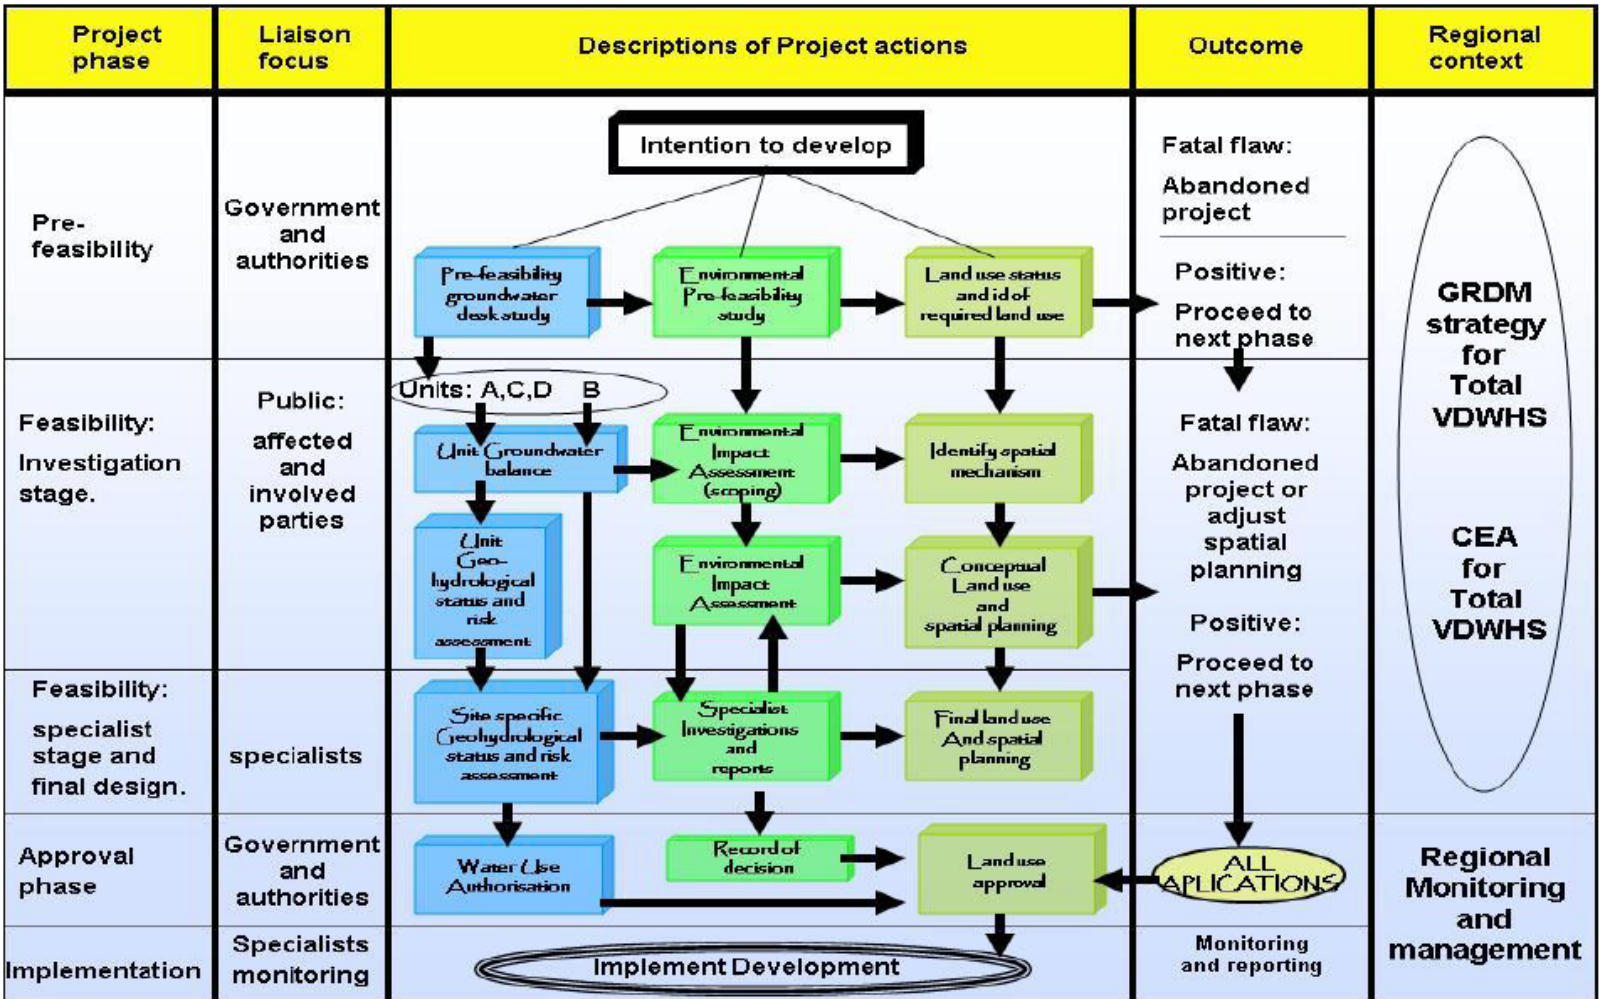
Figure 12. Integration of geohydrological and land use processes: structure of procedures and